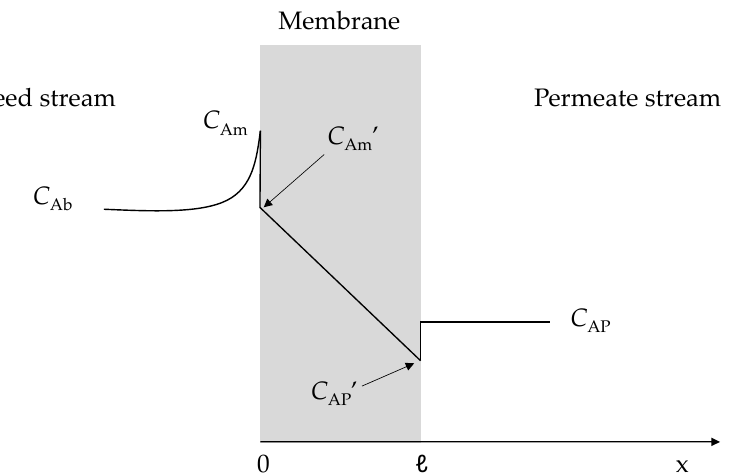
Figure 1. Scheme of the mass transport for a given solute A in an NF membrane by the solution-diffusion model. C Am ’ and C AP ’ are the concentrations of solute A inside the membrane on the feed and permeate sides, respectively. Adapted from [25].